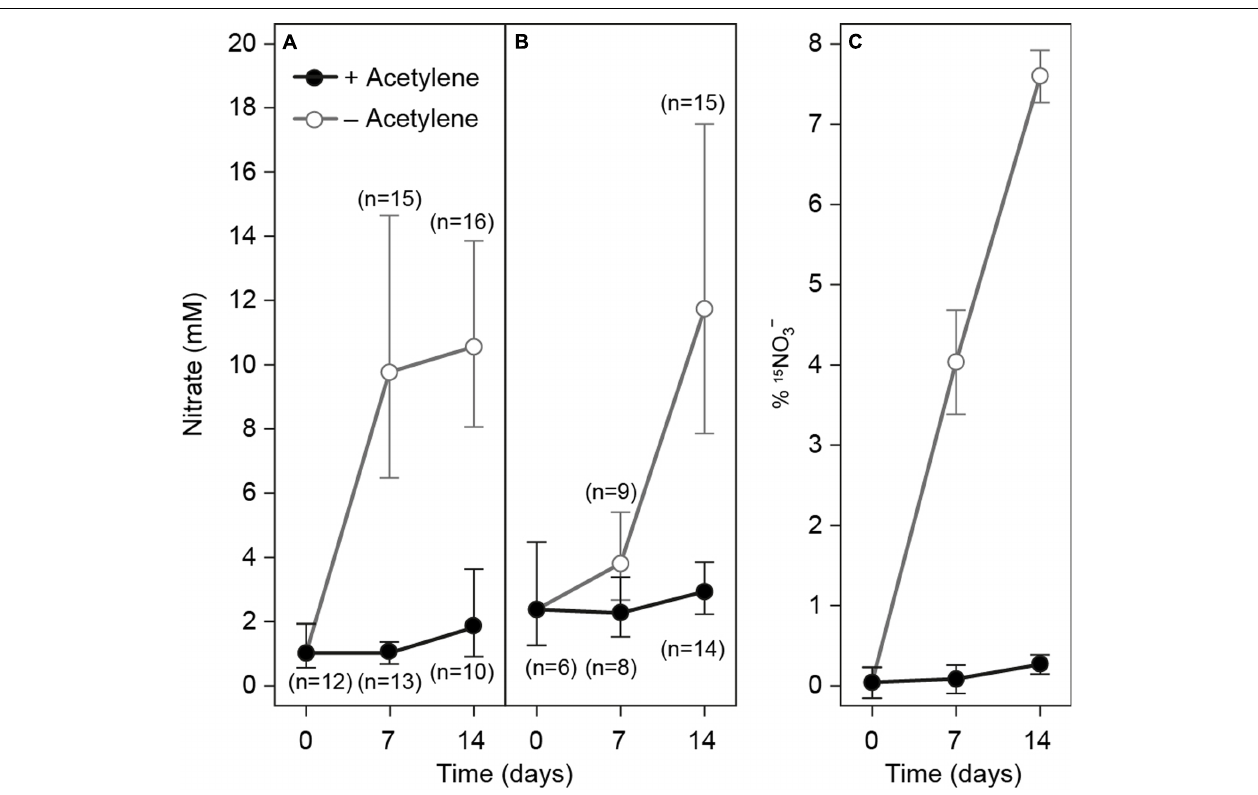
FIGURE 4 | Intracellular nitrate concentrations in gromiids that were incubated without nitrate in the media and either with (black circles) or without acetylene (Gray circles). (A) No ammonia amendments. (B) Media supplemented with 50 µ M 15 NH 4 + and (C) 15 N labeling percentage of ICN in gromiids from the experiment shown in (B) . Error bars are 95% confidence intervals for ICN and standard error of the mean for labeling percentages. Numbers in parenthesis refer to the number of individuals picked for